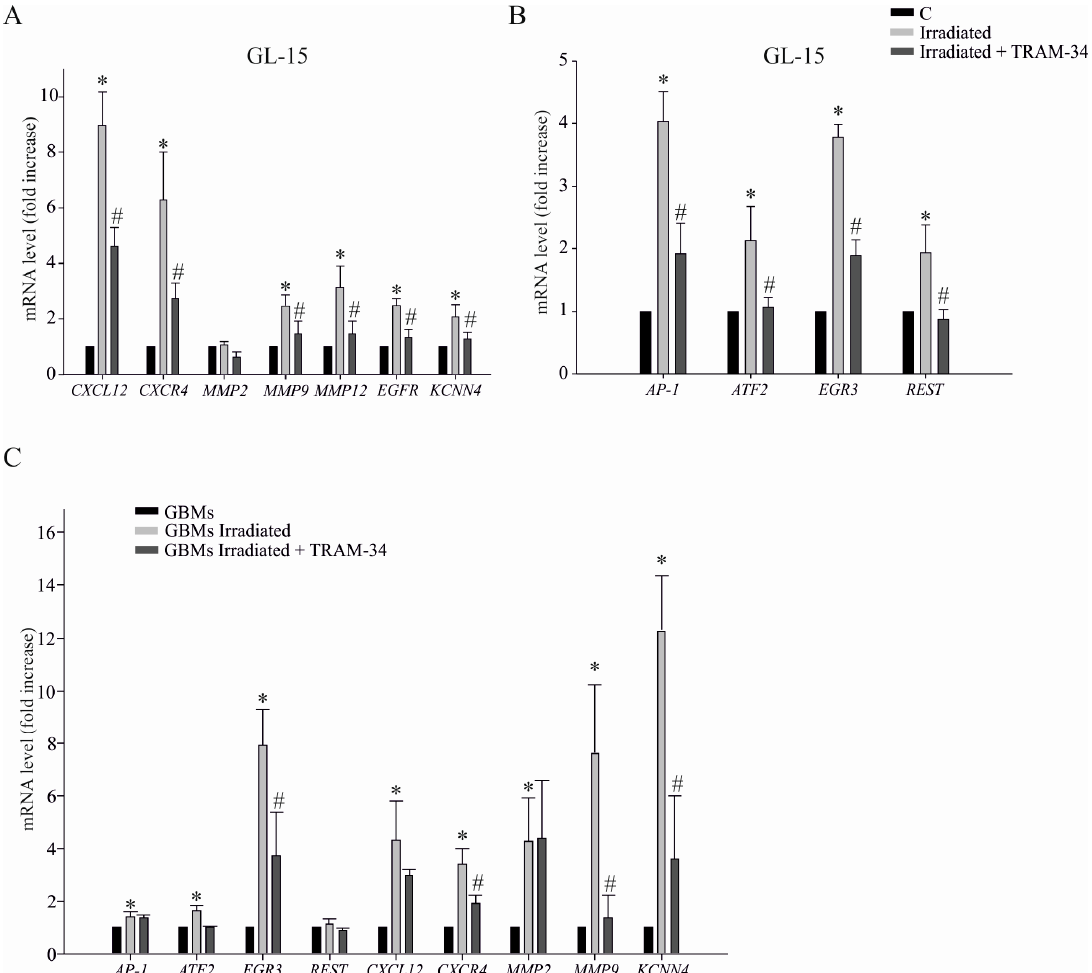
Figure 3. ( A , B ) Expression analysis by qRT-PCR of invasion-related genes in irradiated or control, (C) GL-15 cells upon TRAM-34 treatment (5 µM, 48 h); * p < 0.05 vs. control GL-15. # p < 0.05 vs. irradiated GL-15 n = 3 (in duplicate). ( C ) Same as in A and B for human primary GBM cells, upon TRAM-34 treatment (5 µM, 48 h); * p < 0.05 vs. GBMs. # p < 0.05 vs. irradiated GBMs n = 3